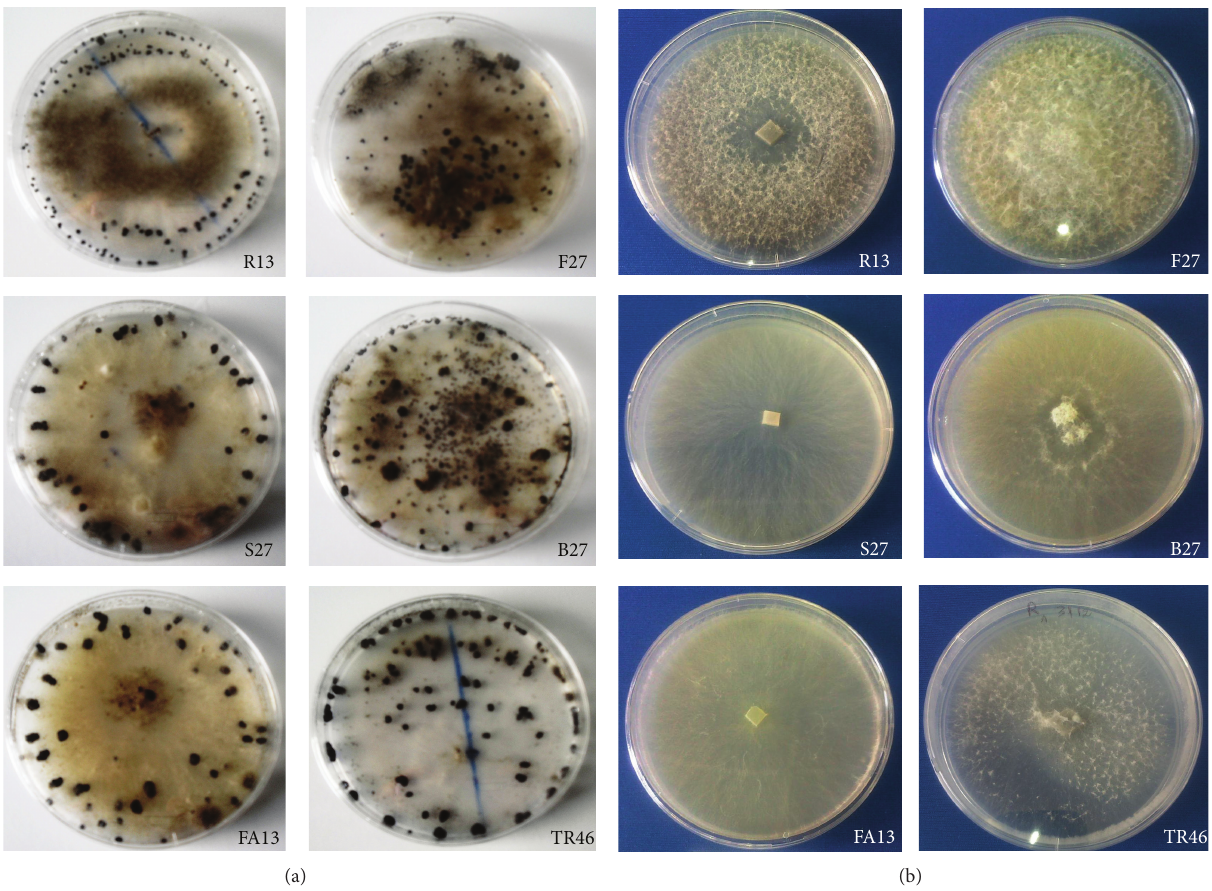
Figure 1: Morphological types of B. cinerea . (b) Mycelial growth on potato dextrose agar (PDA) medium at 25 ∘ C after two weeks. (a) Distribution and pattern of sclerotia formation on the surface of PDA after 4